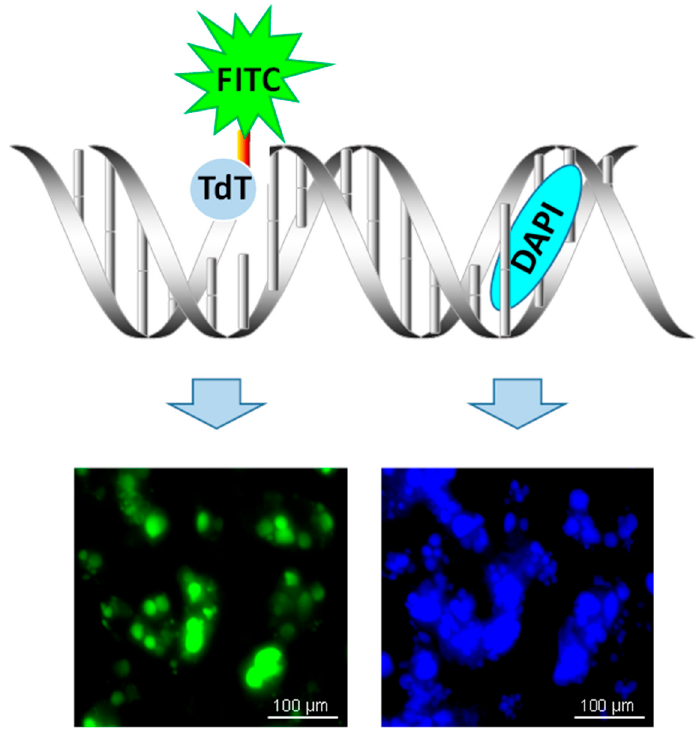
Figure 1. Terminal deoxynucleotidyl transferase dUTP nick-end labeling (TUNEL) assay schematic. Terminal deoxynucleotidyl transferase (TdT) reacts with fluorescein (FITC)-labeled dUTP to attach uridine to 3 ′ -hydroxyl (3 ′ OH) terminus in DNA strand breaks. Double-stranded DNA is counterstained by DAPI that intercalates between strands of double-stranded DNA.